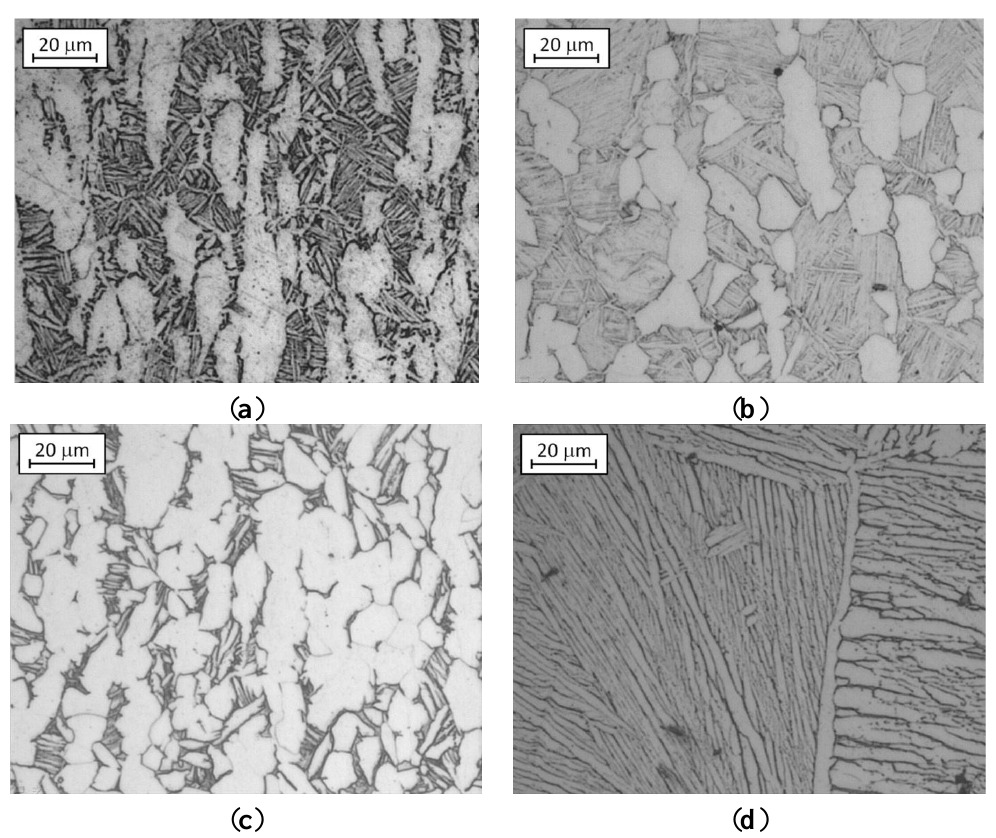
Figure 1. Optical microscope images of Ti6Al4V microstructures: ( a ) mill annealed; ( b ) bimodal; ( c ) fully equiaxed and ( d ) fully